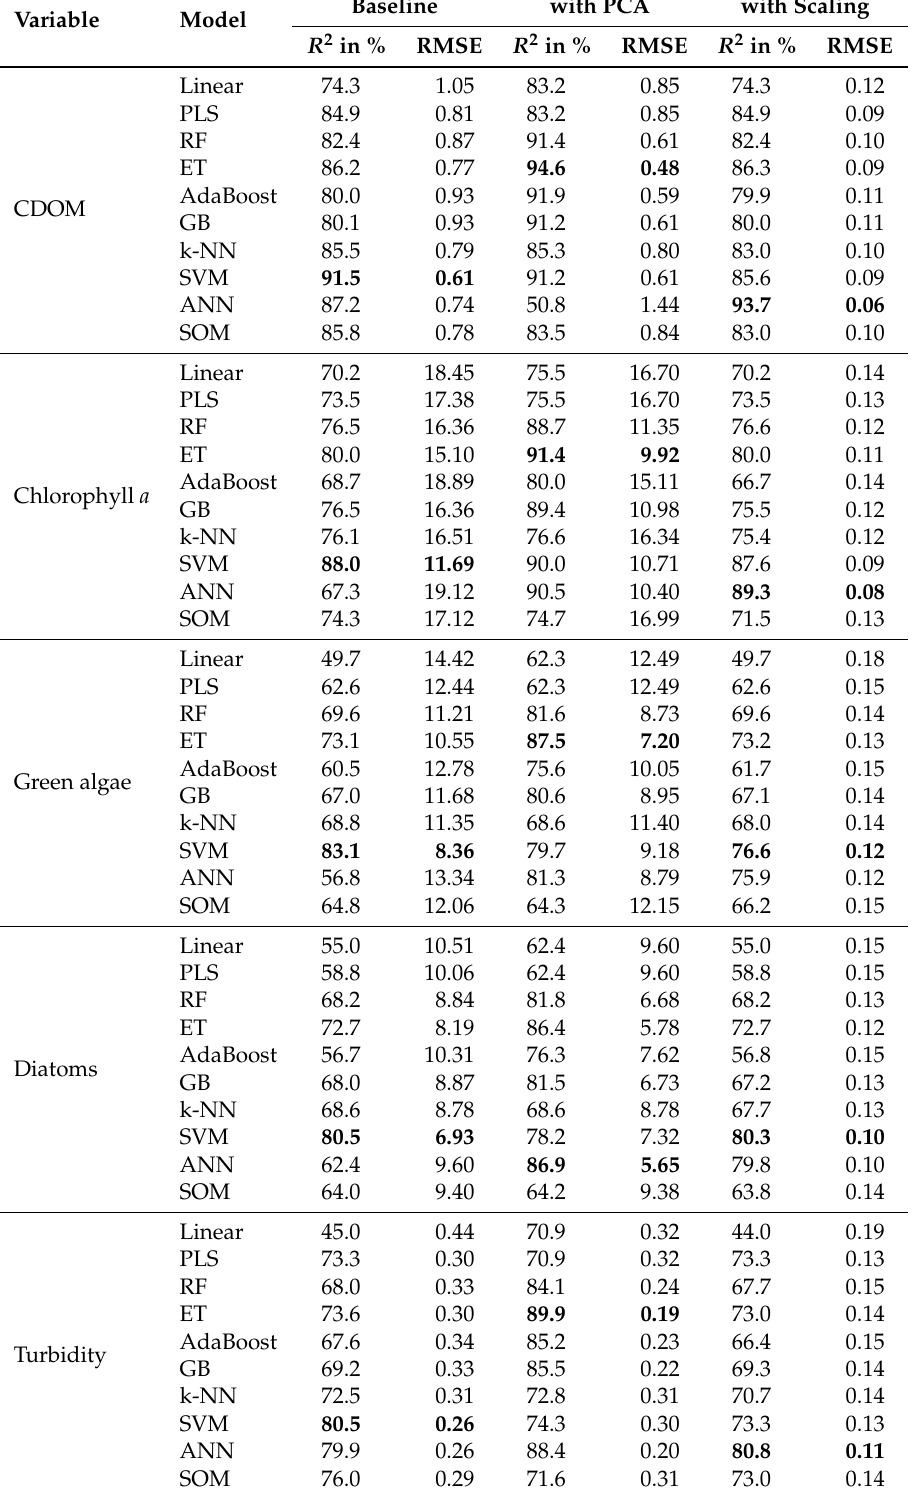
Table 2. Regression results for the estimation of CDOM, chlorophyll a , green algae, diatoms and turbidity. The bold values represent the best regression results, respectively. The RMSE is given in the respective units of the target variables. After applying min-max scaling, the RMSE is